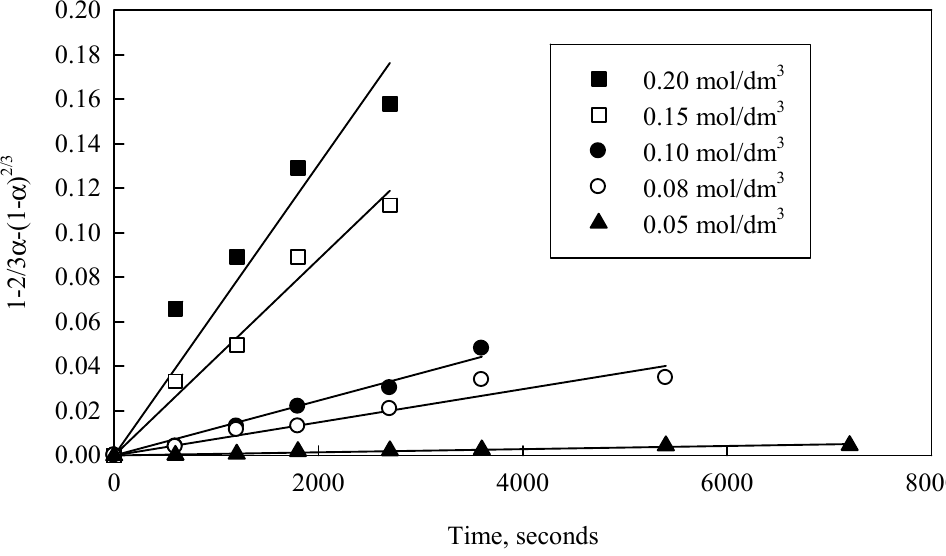
Figure 13. Evaluation of the kinetic model for different ammonium hydroxide concentrations. Working conditions are the same as those in Figure 8.